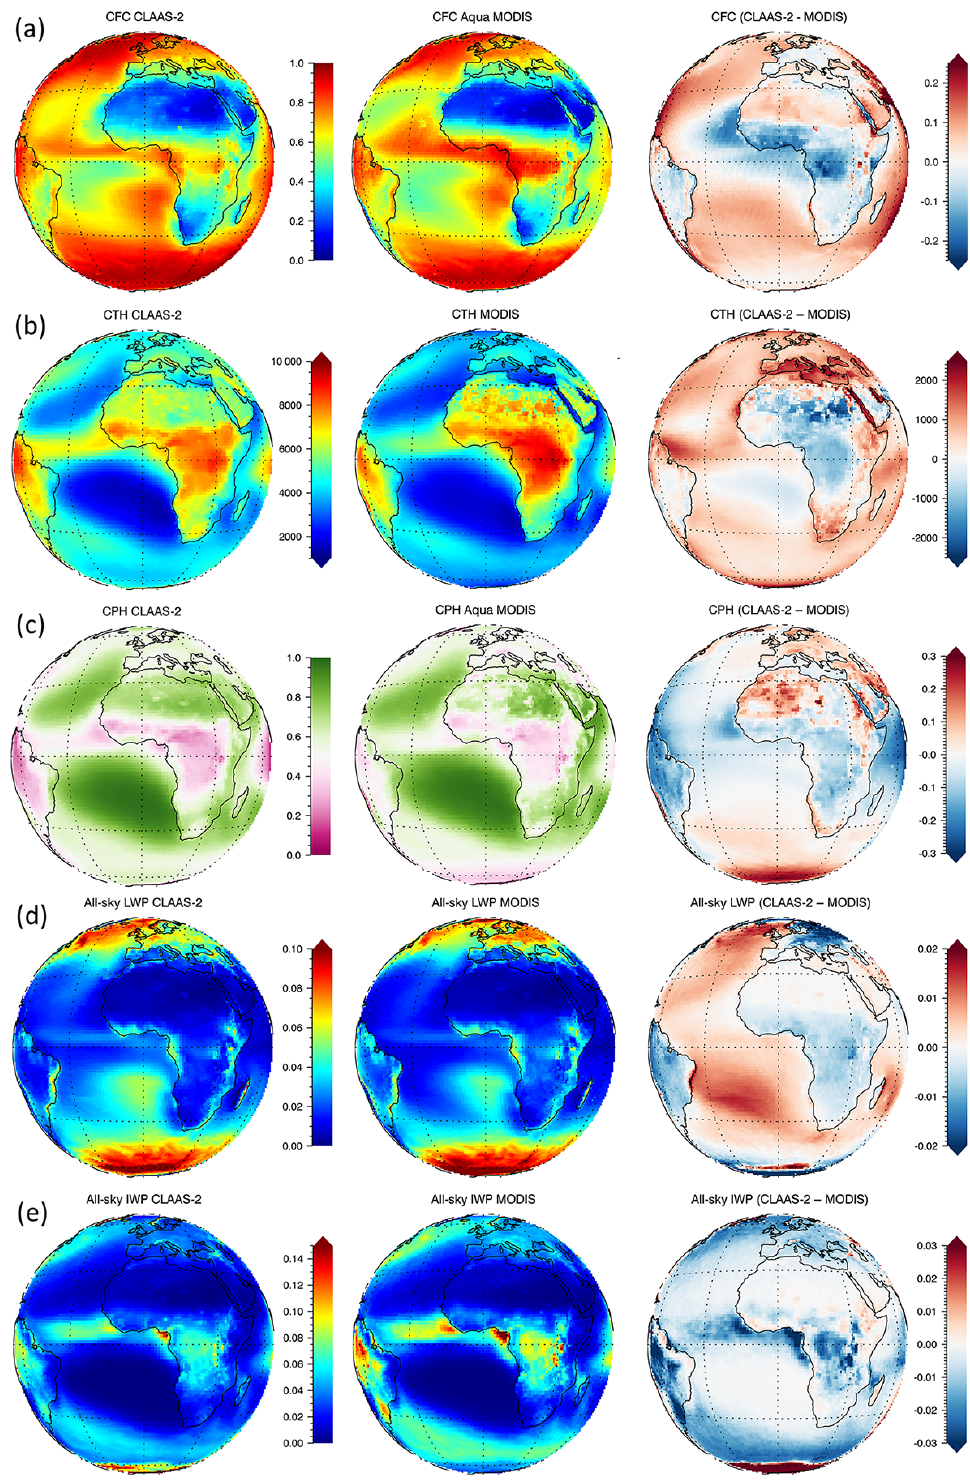
Figure 10. Spatial distributions of CFC (a) , CTH (b) , CPH (liquid cloud fraction) (c) , all-sky LWP (d) and all-sky IWP (e) averaged from February 2004 until December 2015 from CLAAS-2 (left column) and MODIS (middle column). The right column shows the corresponding differences. Aqua MODIS data were used in (a) and (c) ; average Aqua and Terra MODIS data were used in (b) , (d) and (e) . Units are 1 (a, c) , m (b) and kgm − 2 (d, e)